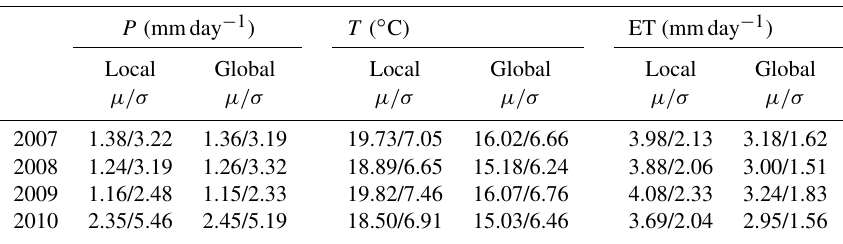
Table 1. Catchment daily mean ( µ )/standard deviation ( σ ) of precipitation ( P ), temperature ( T ) and reference evapotranspiration (ET) in the Murrumbidgee River basin for 2007–2010.